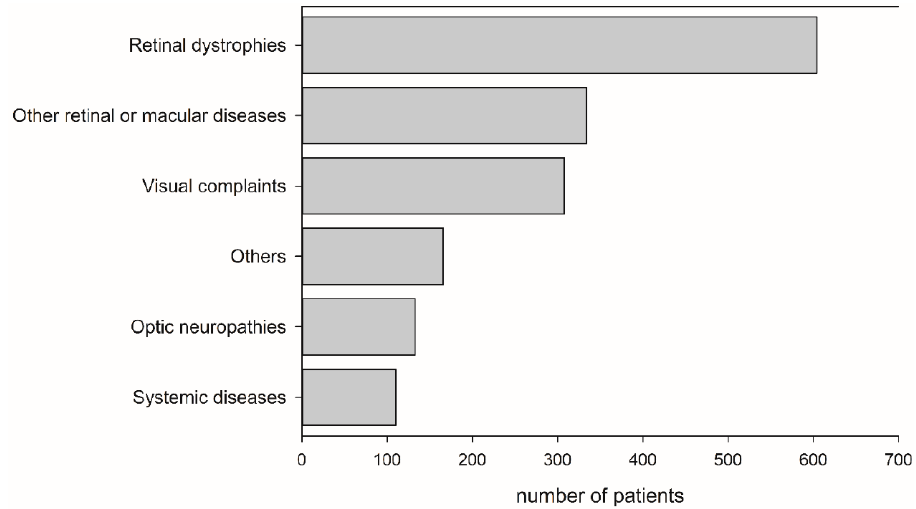
Figure 1. ( A ) Distribution of patients’ ages when receiving their first ffERG during the study period. ( B ) Cumulative number of ffERG examinations per year in this single tertiary medical center.